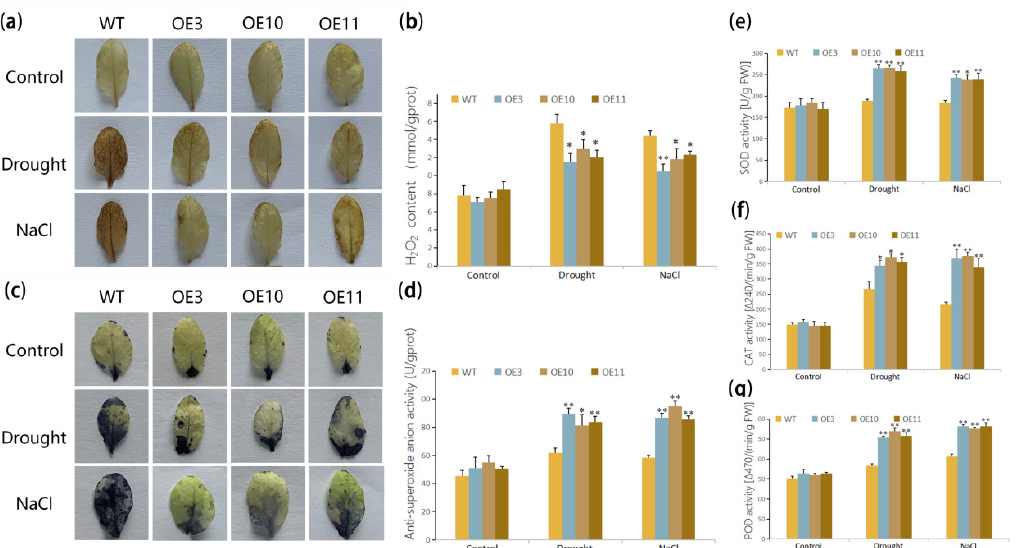
Figure 6. Alterations in reactive oxygen species (ROS) levels and antioxidant enzyme activities in MfWRKY70 transgenic and WT Arabidopsis. ( a , b ) Histochemical staining by 3, 3 ′ -diaminobenzidine (DAB) ( a ) and nitroblue tetrazolium (NBT) ( b ); ( c , d ) H 2 O 2 content and anti-superoxide anion activity in MfWRKY70 transgenic and WT Arabidopsis. ( e – g ) Alterations of Activities of antioxidant enzymes superoxide dismutase (SOD) ( e ), catalase (CAT) ( f ), and peroxidase (POD) ( g ). Asterisks indicate significant difference (* p < 0.05, ** p < 0.01, by Student’s t -test) comparing to WT.